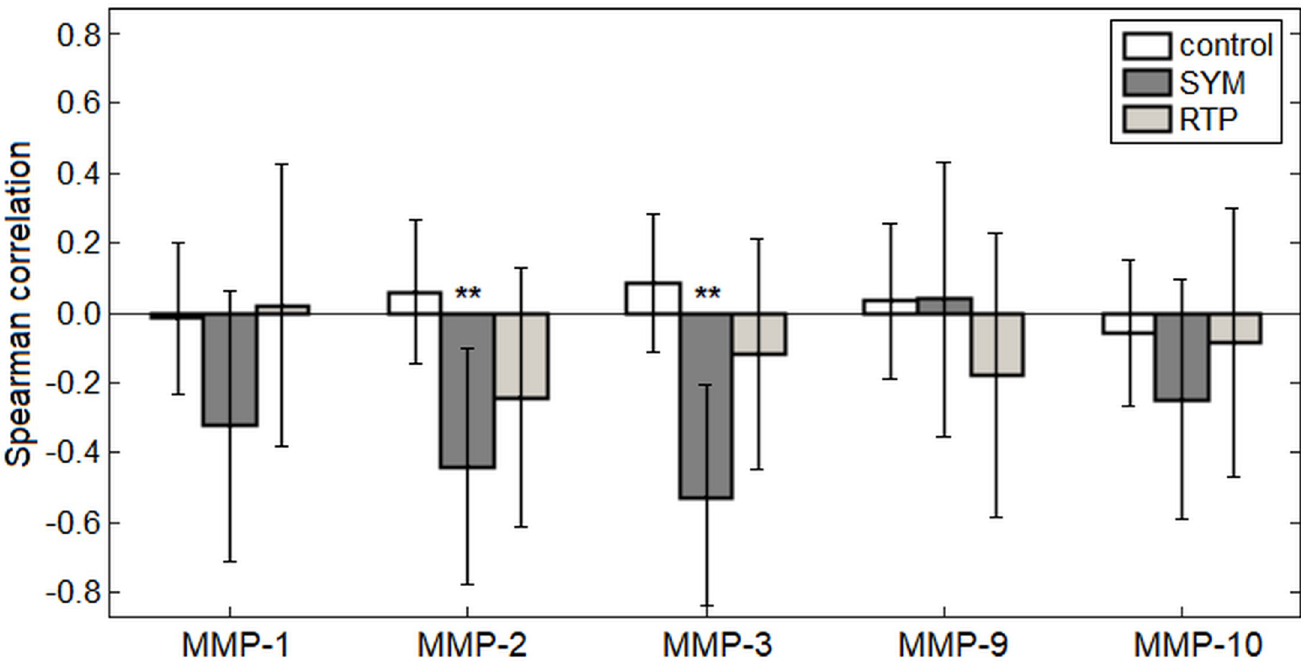
Fig 1. Correlations between matrix metalloproteinase (MMP) concentrations and global cerebral blood flow (CBF). Results are shown for athletic controls and for concussed athletes at early symptomatic injury (SYM) and return to play (RTP). Bars represent Spearman correlations, with error bars corresponding to bootstrapped 95%CIs. ‘ �� ’ denotes significant correlations (i.e., 95%CIs excluding zero) at a False Discovery Rate threshold of 0.05.